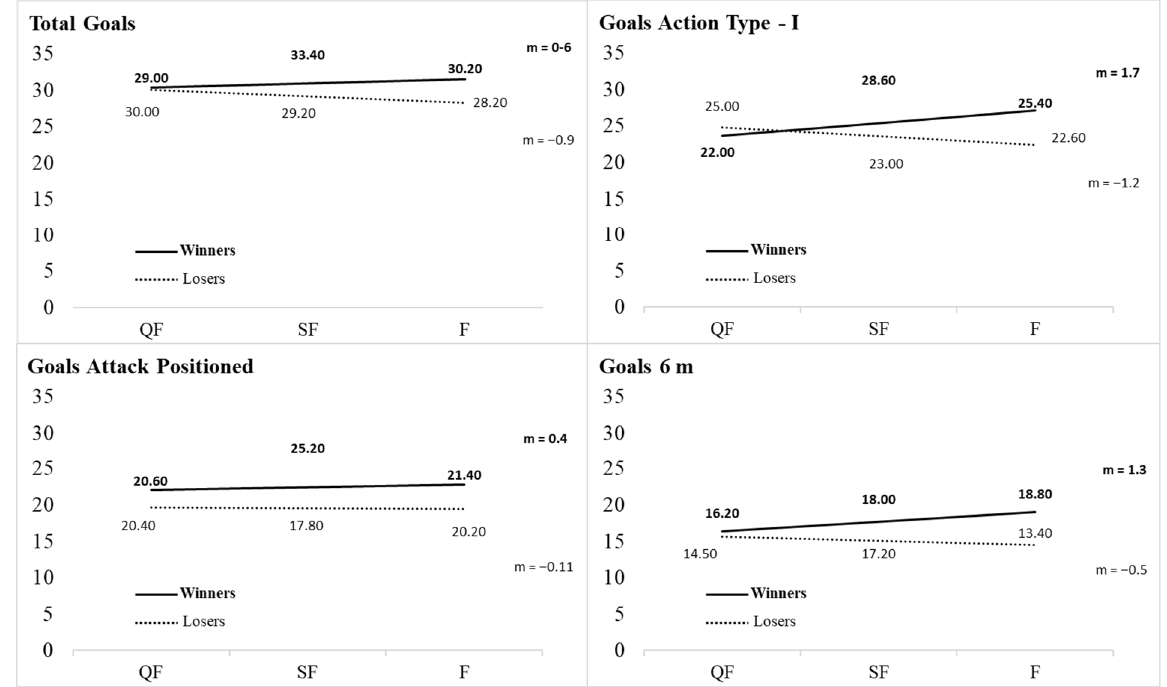
Figure A1. Linear tendency lines of assists performed in matches. Note: QF = Quarterfinals; SF = Semifinals; F = Finals.